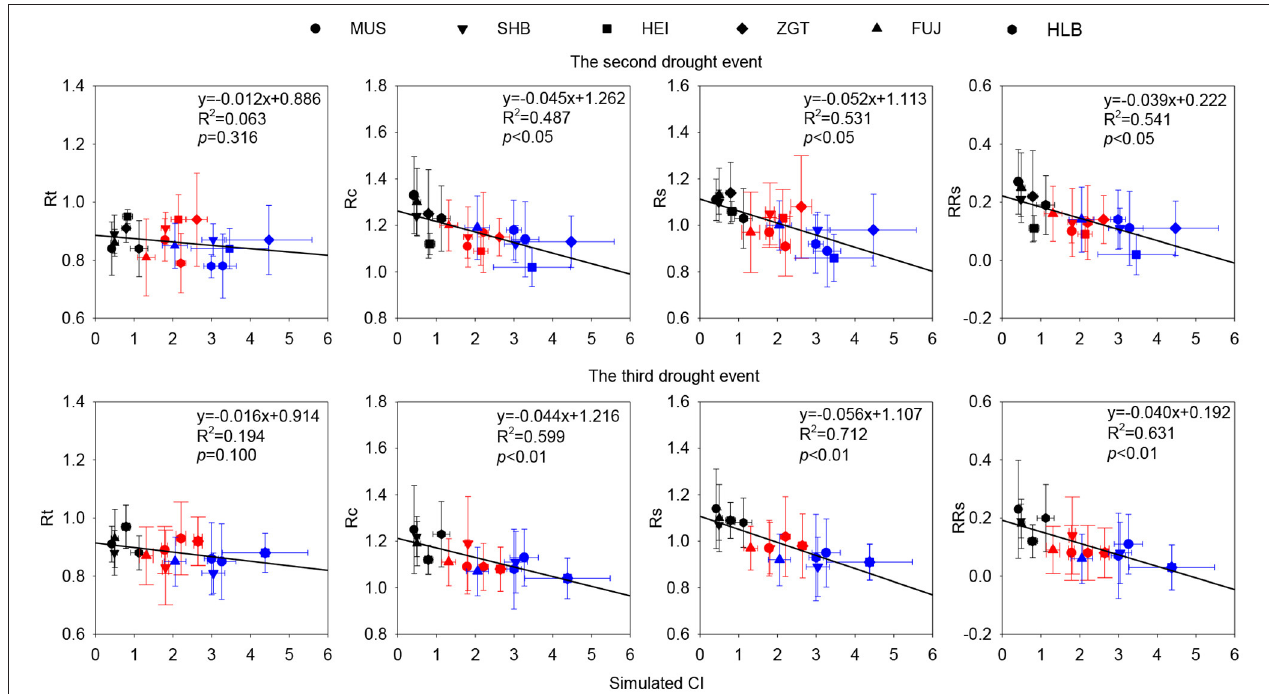
FIGURE 9 | Correlations of simulated competition indices (CIs) with Rc, Rs, and RRs ( p < 0.05) at all densities during the second and the third drought event. Simulated CI was reconstructed with a model of annual series of tree growth rate (Calama et al., 2019). Black, red, and blue symbols represented L-CI, M-CI, and H-CI,